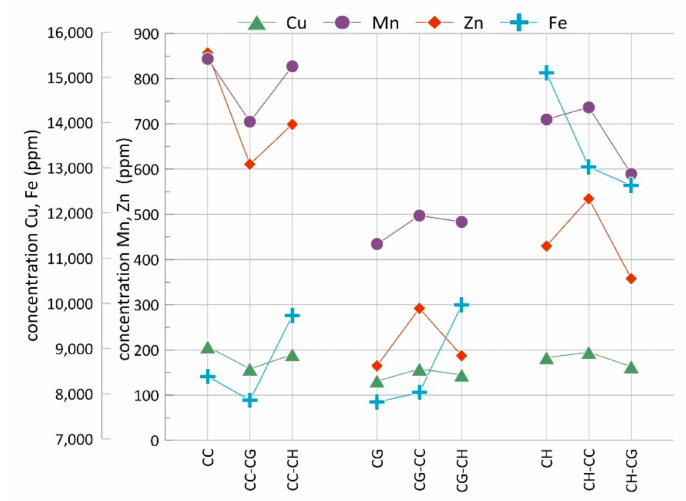
Figure 3. Distribution of microelements in the ashes of the examined raw